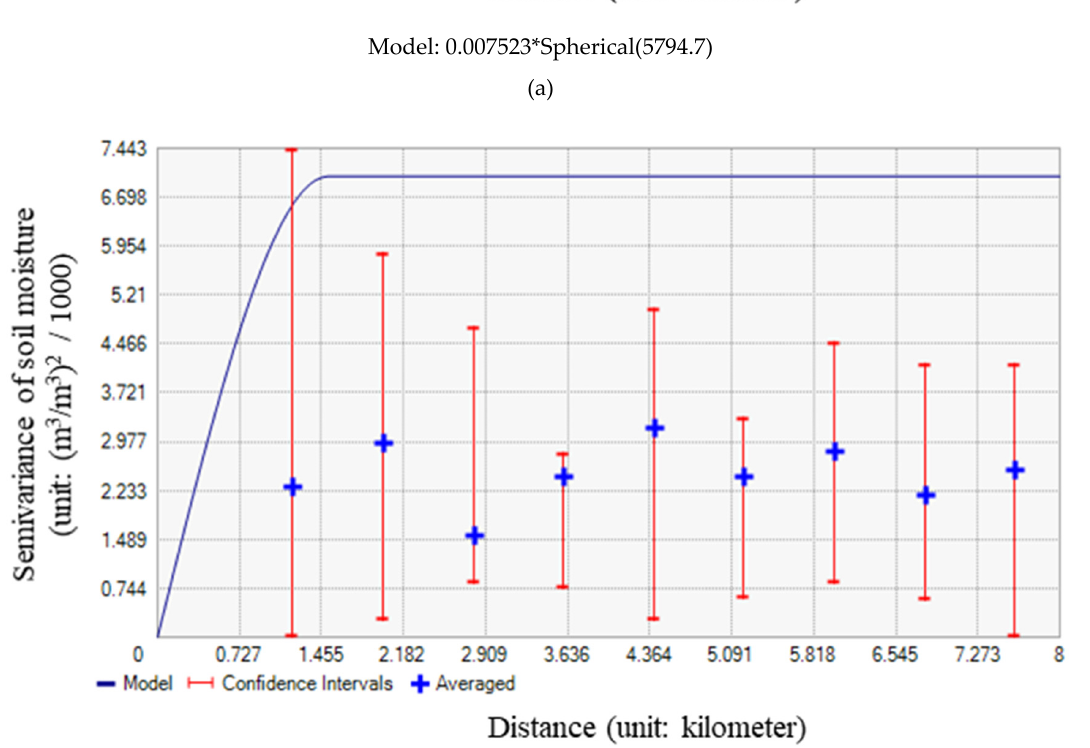
Figure 5. Semivariograms from the block kriging for the spatial autocorrelation. ( a ) Scenario a shows spatial autocorrelation detected in grid 2; ( b ) scenario b shows spatial autocorrelation not detected in grid 11. The semivariogram depicts the spatial autocorrelation of the measured sample soil moisture stations (points). A model (blue line) is fit through the average of each pair of locations (blue-colored crosses). The semivariograms for the two scenarios were modeled by spherical equations, which are the mathematical description of the two blue